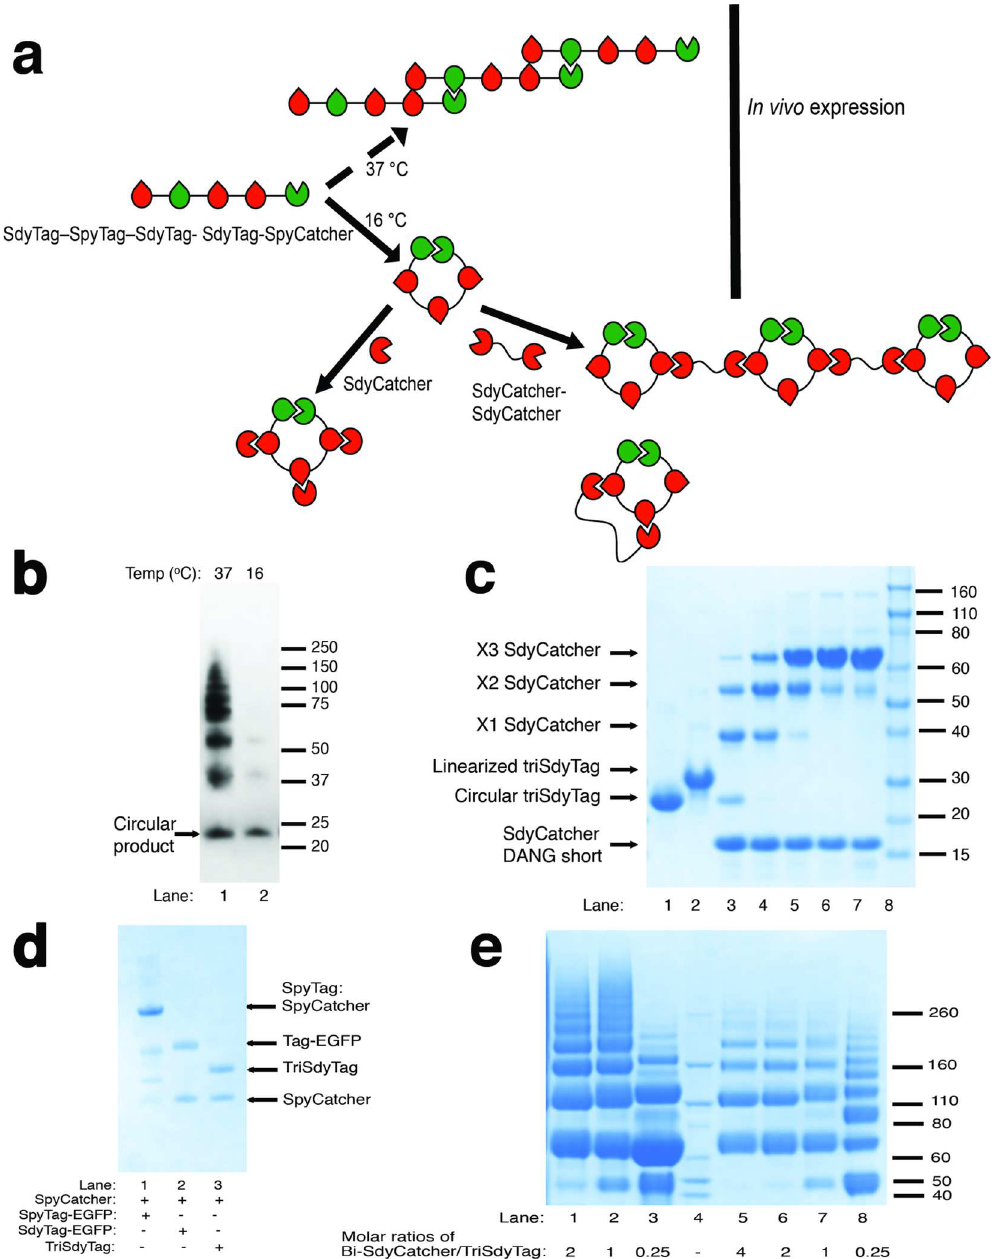
Fig 5. Construction and polymerization of circular proteins. (a) Schematics for in vivo and in vitro ligations of triSdyTag constructs. (b) Western blot showing E . coli lysates for the production of triSdyTag with 100 μ M IPTG, 16˚C (lane 2) and 37˚C (lane 1). (c) Characterization of triSdyTag. Lane 1: Purified triSdyTag, lane 2: purified triSdyTag after TEV digestionovernight,lanes 3–7: reaction of SdyCatcher DANG short and triSdyTag at 1, 5, 20, 90 minutes and overnight at 25˚C, pH 7 and lane 8: Novex Sharp ladder. (d) Presence of free SpyTag was examined by reaction of SpyCatcher with either SpyTag-EGFP (lane 1), SdyTag-EGFP (lane 2) or circularized triSdyTag (lane 3) at 5 minutes, pH 7, 25˚C. Only SpyTag-EGFP (lane 1) has a product (SpyTag-EGFP:SpyCatcher) with SpyCatcher under these conditions. (e) Polymerization of tri-SdyTag. Lanes 1–3: Reaction of bi-SdyCatcher with triSdyTag at 30 μ M in 2:1, 1:1, 1:4 Catcher: Tag molar ratios, lane 4: Novex Sharp ladder and lanes 5–8: reaction of bi-SdyCatcher with triSdyTag at 10 μ M in 4:1, 2:1, 1:1, 1:4 Catcher: Tag molar ratios. The reactions were left overnight at 25˚C, pH